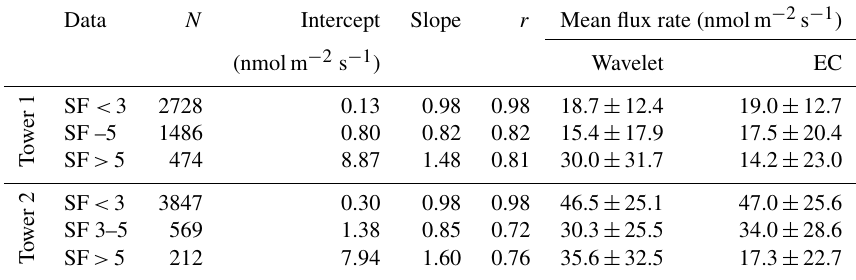
Table 3. Statistical coefficients of an orthogonal regression analysis (wavelet = intercept + slope × EC) and mean flux rates for the two processing methods separated by stationarity classes (SF < 3 as high, SF 3–5 as medium and SF > 5 as low